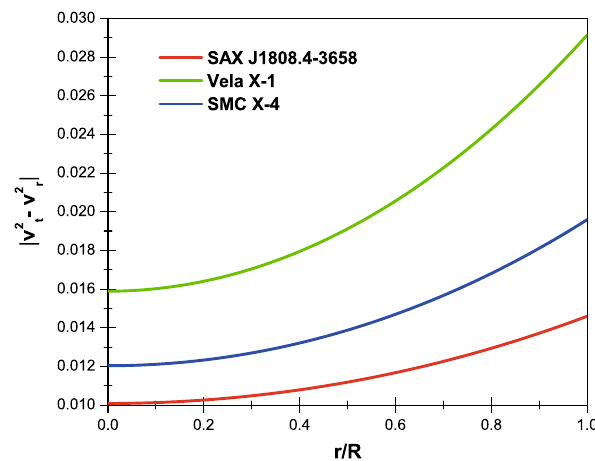
Fig. 18 TOV equation for the strange star candidate Vela X-1 versus the fractional radial coordinate for α = 0 . 3